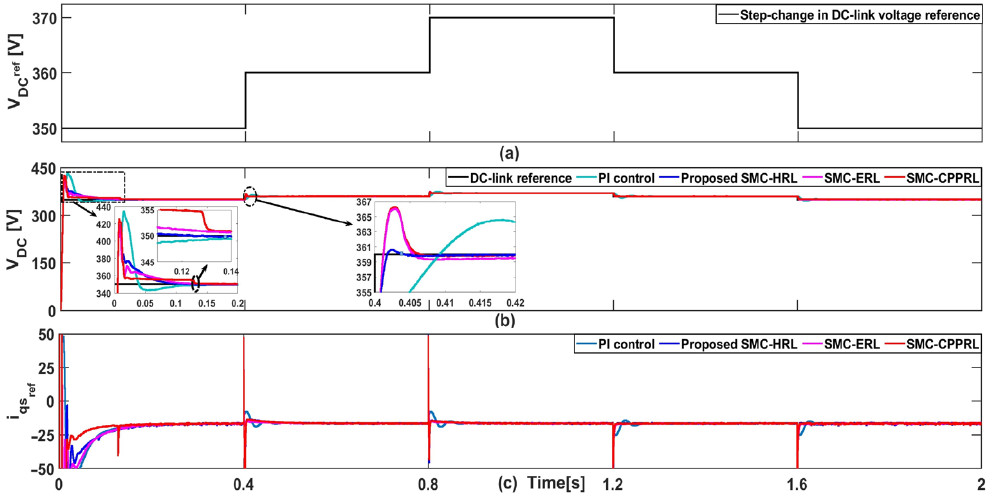
Figure 4. Simulation responses of DC-link voltage for step-change reference value. ( a ) Step-change in DC-link reference. ( b ) DC-link voltage. ( c ) DC-link control input.